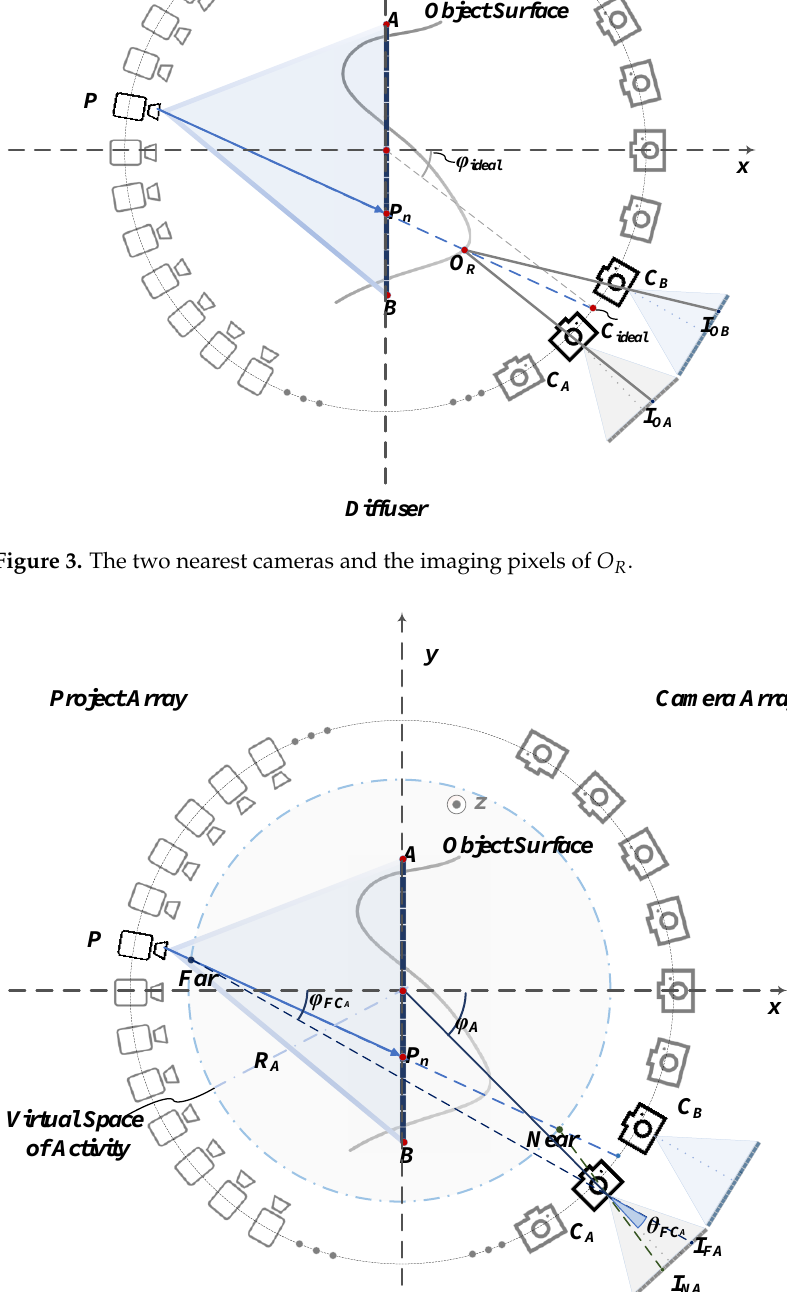
Figure 4. Virtual activity space and interval of the imaging pixels .